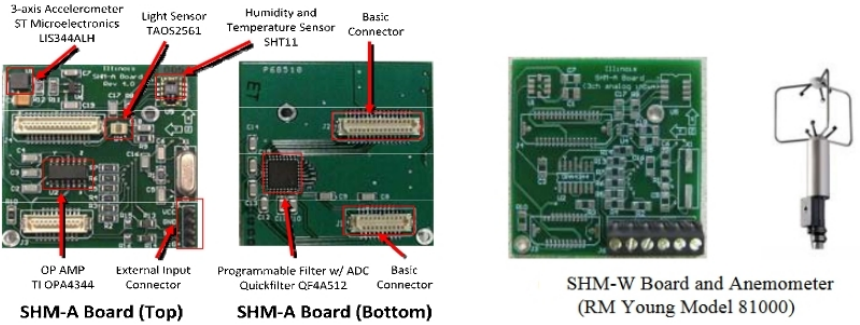
Figure 11. Hardware units of SHM-A( left ) and SHM-W board wireless smart sensors ( right ) [79]. Polyvinylidene fluoride (PVDF), a piezoelectric polymer material, was proposed in WSN design in order to report and read the displacement and strain from PVDF thin film [80,81]. Moreover, the IEEE802.15.4 wireless communication standard was utilized. In